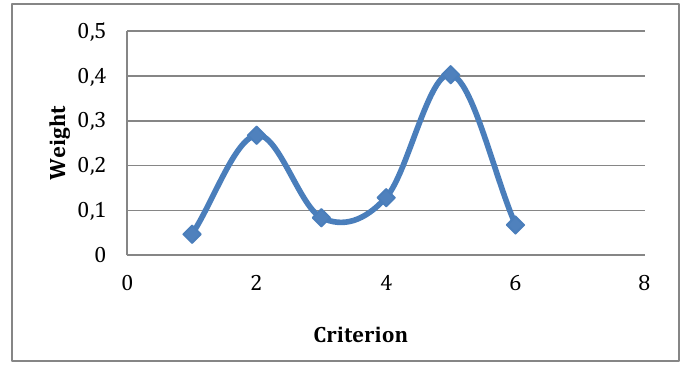
Figure 10: Sustainability assessment of remanufactured milling as a remanufacturing technology comparing with CNC grinding